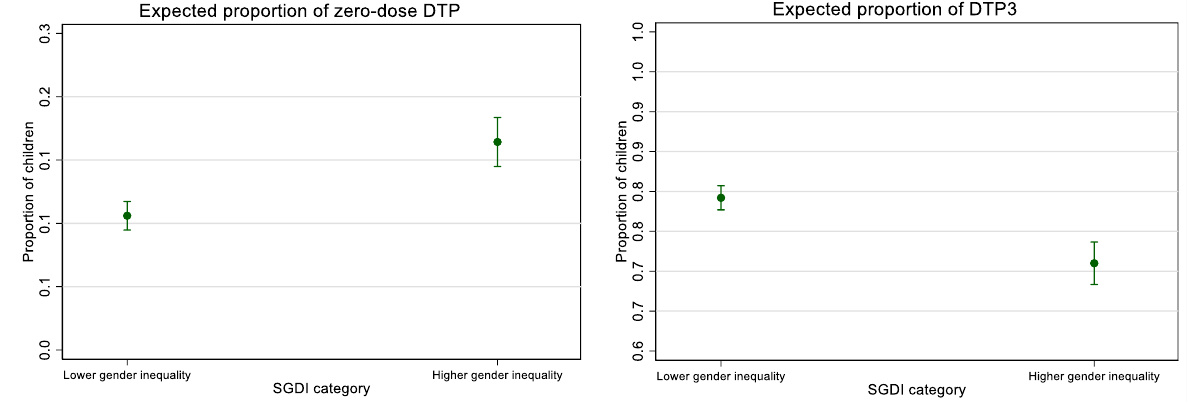
Figure 4. Adjusted * expected proportions of zero-dose DTP and DTP3 immunization coverage by SGDI category, 702 subnational regions across 57 countries, 2010–2019. Estimated proportions are adjusted for annual population growth and age structure (measured as the percentage of the popula- tion under 15 years of age), percentage of urban population, and the three individual dimensional indices of the SHDI (health index, education index, and income index).